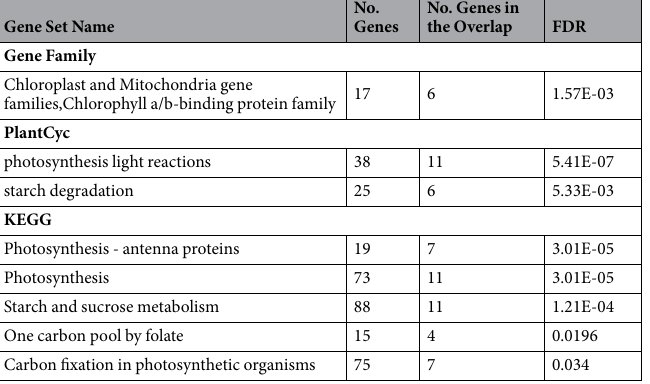
Table 1. Enriched gene sets among DHS-diminished and down-regulated genes under extended